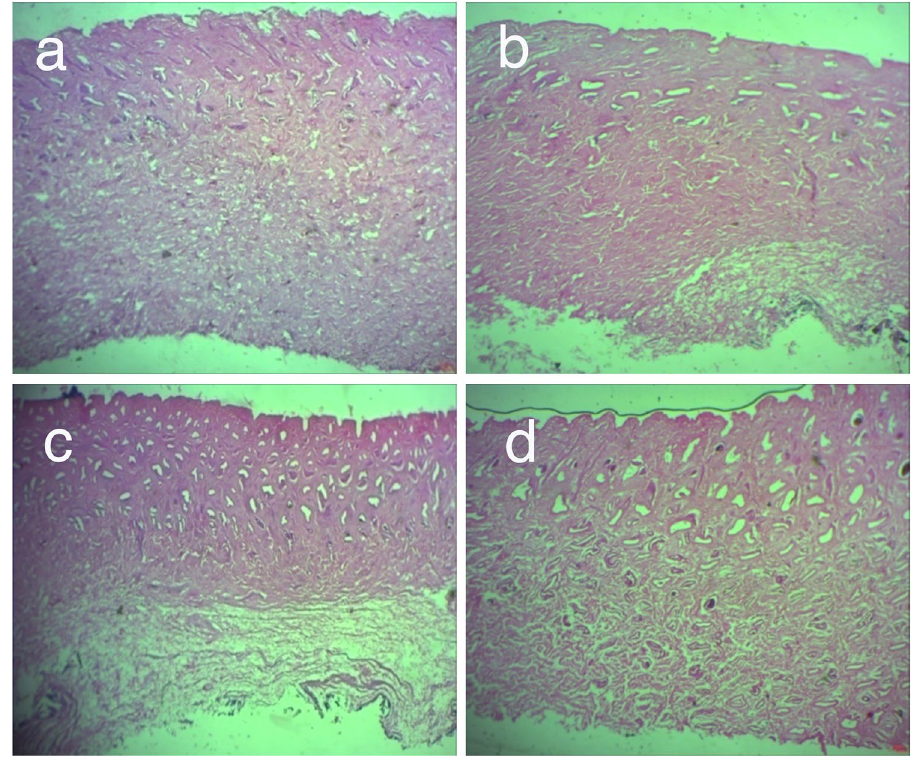
Figure 5. H&E stained sections of opened up sheep skins as viewed under a compound microscope at 100× magnification. ( a ) Control (water), ( b ) Heptane, ( c ) Propylene glycol and ( d ) PEG